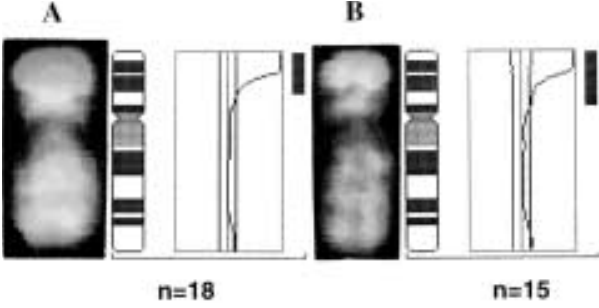
Fig. 2. High-level amplification at chromosome arm 9p21-pter in 2 cases. The line in the middle of the profile indicates the base line ratio (1.0), the lines to the left and right indicate ratio values 0.5 and 1.5, respectively. A, case 3; B, case 4; n , number of chromosomes counted to provide the